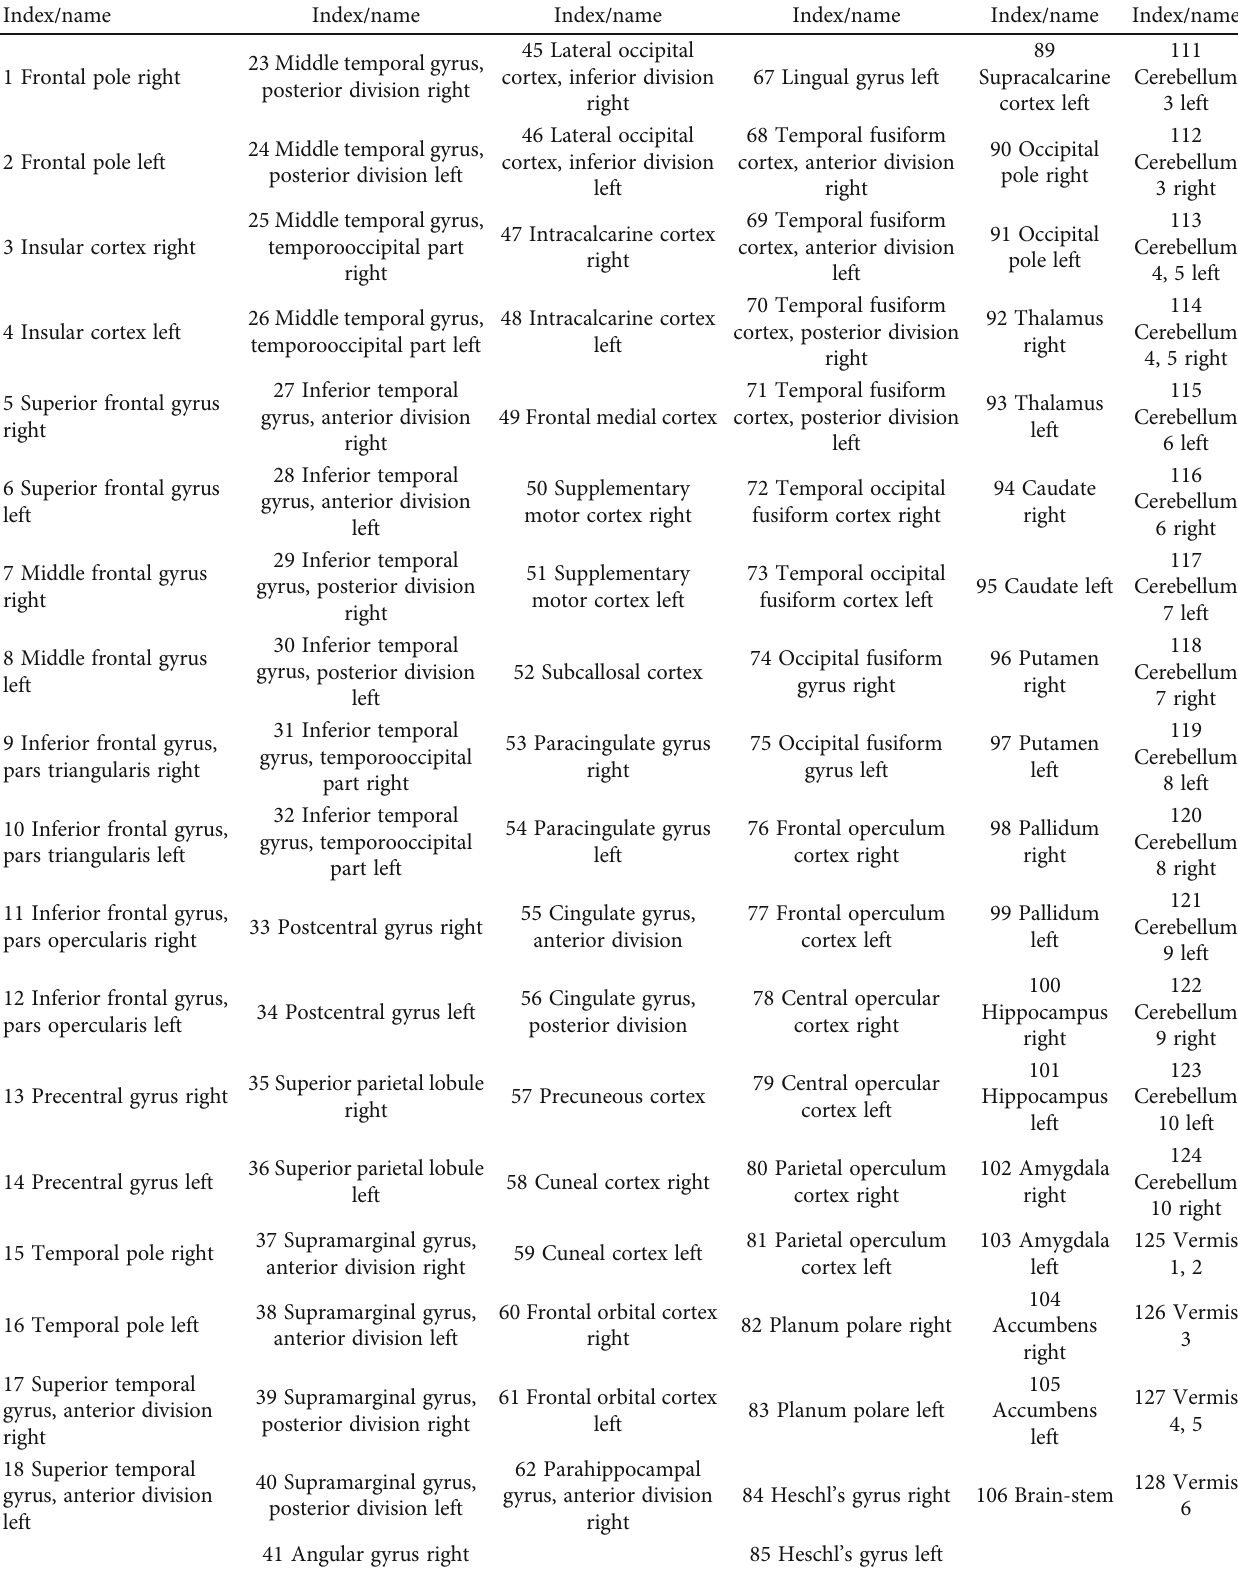
Table 2: Index and name of 132 brain parcels, including 91 cortical, 15 subcortical, and 26 cerebellar subregions. This parcellation atlas was based on FSL Harvard-Oxford and the automated anatomical labeling (AAL)